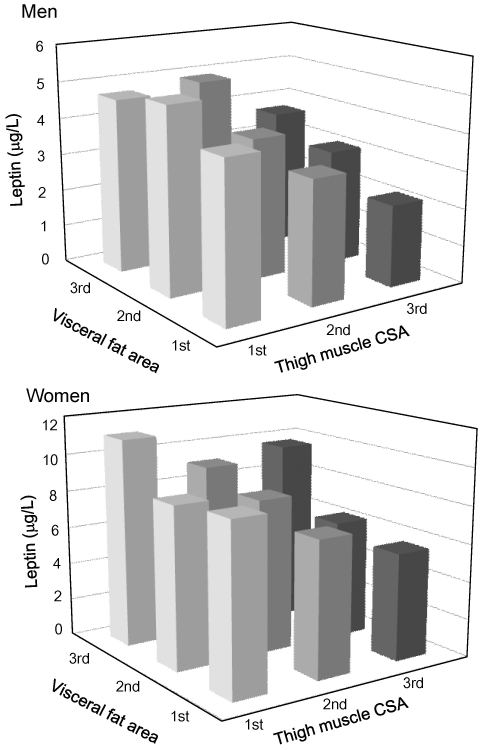
Plasma leptin levels in tertiles of visceral fat area and thigh muscle cross-sectional area (CSA).Multiple regression analysis was performed for plasma leptin concentration with the following parameters in each sex: age, body weight, body height, tertiles of visceral fat area, tertiles of thigh muscle CSA, and interaction and interaction between visceral fat and thigh muscle tertiles. All values are mean values. Men: Visceral fat area tertile: F = 5.1, p = 0.007. Thigh muscle CSA tertile: F = 8.5, p = 0.0003. Interaction: F = 1.5, p = 0.33. Women: Visceral fat area tertile: F = 7.6, p = 0.0006. Thigh muscle CSA tertile: F = 5.2, p = 0.006. Interaction: F = 1.1, p = 0.34.